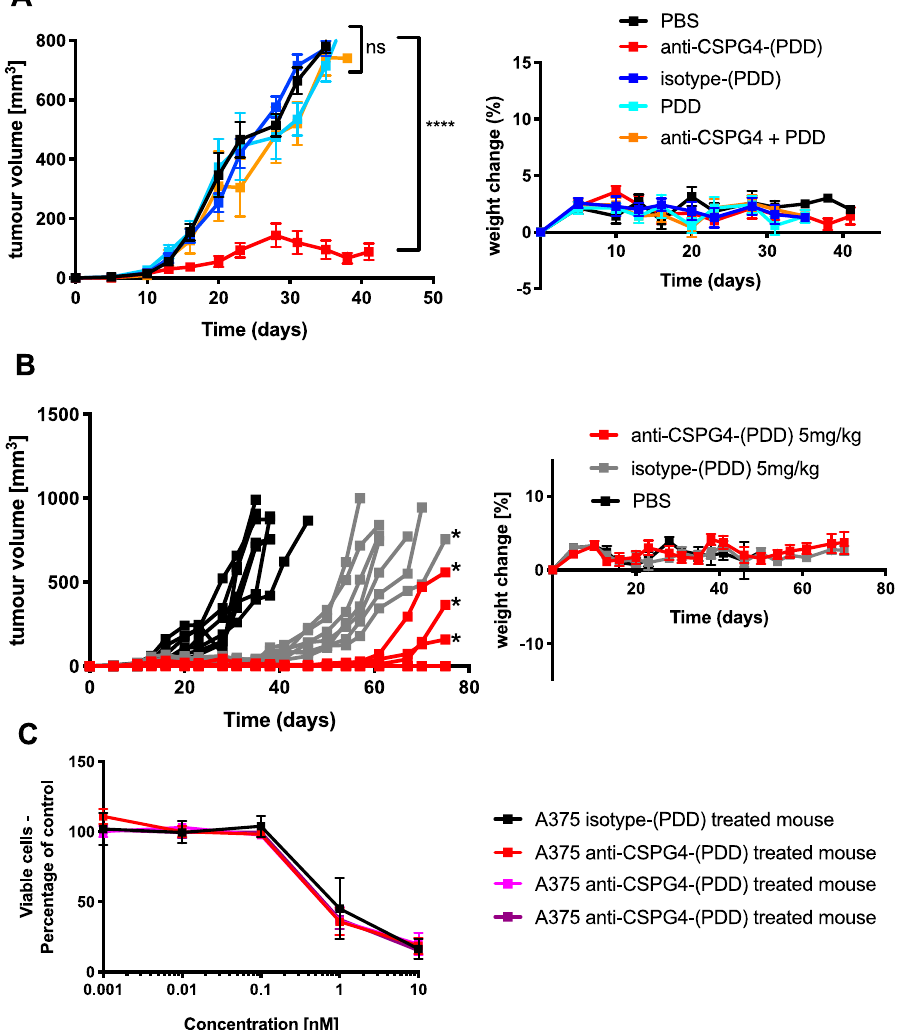
Figure 6. Anti-CSPG4-(PDD) restricts tumor growth in vivo in a melanoma xenograft with low toxicity profile. ( A ) Growth curves of A375 human tumor xenografts in female athymic nude mice (mean ± SEM, left panel) and mouse weights (mean ± SD (right panel, N = 7 mice per group), treated with anti-CSPG4-(PDD) ADC, isotype-(PDD) control ADC, PDD alone, a combination of the anti-CSPG4 antibody and non-conjugated PDD or PBS vehicle control with two doses of 2 mg / kg at days 10 and 24 post tumor inoculation. (**** p < 0.0001, by Dunnett’s multiple comparisons test). ( B ) Growth curves of A375 human tumor xenograft in female athymic nude mice (single lines [left panel]; mouse weight mean ± SD (right panel); N = 7 mice per group, treated with anti-CSPG4-(PDD) ADC, isotype-(PDD) control ADC, or PBS vehicle control with one dose of 5mg/kg at day 10 post tumor inoculation, * indicates harvested tumors used for ex vivo study in ( C ) below, (**** p < 0.0001, by Dunnett’s multiple comparisons test). ( C ) Ex vivo cell viability (MTS) of A375 cells from anti-CSPG4-(PDD)- and isotype-(PDD)-treated mice (harvested tumors marked by *). Tumor cells were treated with anti-CSPG4-(PDD) ( N = 3 independent experiments, each condition performed in triplicate, error bars represent standard deviation [SD]).